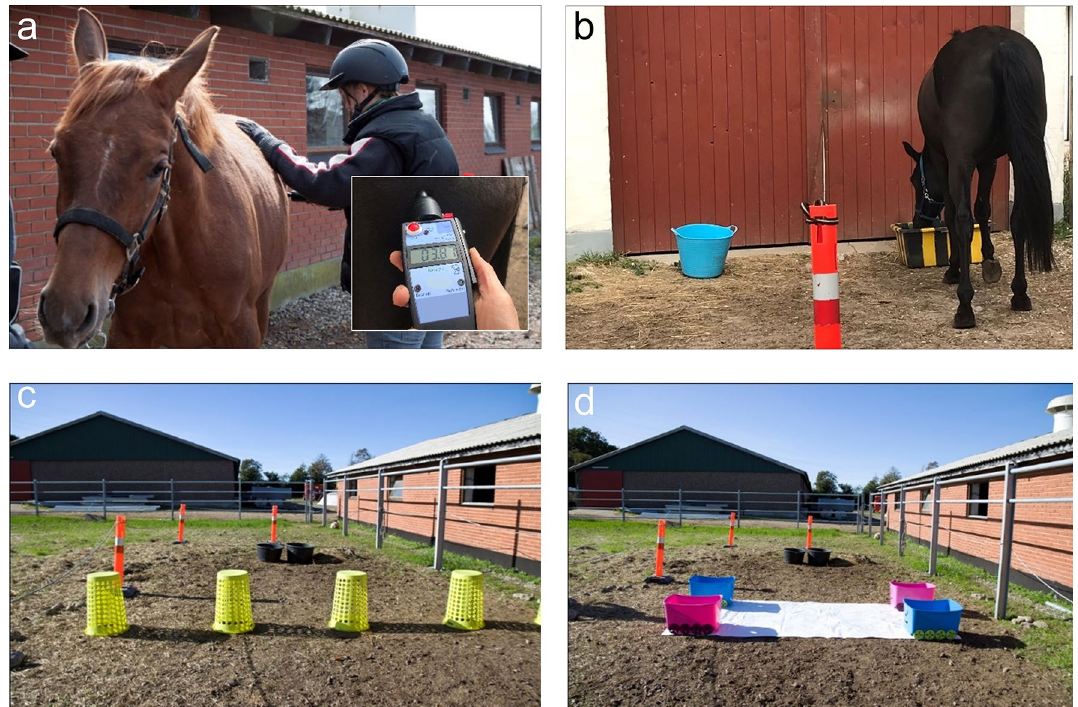
Figure 3. Learning and novel object tests conducted with the 1-year old horses. ( a ) Negative Reinforcement task (NR) in which pressure was applied with an algometer on the horse’s hindquarter at a pre-set increasing rate until the horse showed the correct response, i.e. moving a step to the side; ( b ) Visual Discrimination task (VD) where the horse should learn than only one of the two distinct containers contained food; ( c ) Novel Object Test 2 (NOT2); ( d ) Novel Object Test 1 (NOT1_yearling), which was similar to the 5 months test, except without the mare